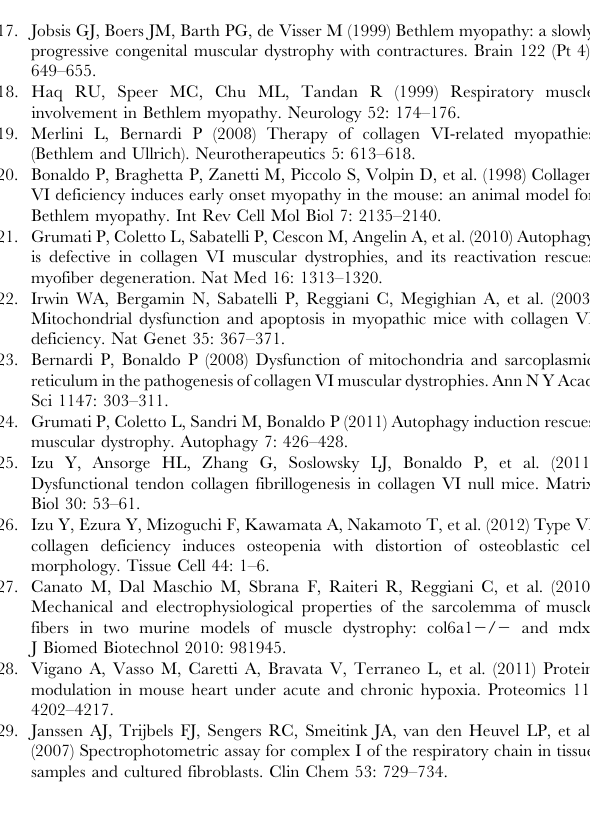
Figure S4 Schematic representation of the different a - ketoglutarate fate in muscles from Col6a1 2 / 2 mice. The direction of IDH1 reaction is controlled by alterations in TCA cycle fluxes leading to the production of anabolic substrates for gastrocnemius and tibialis anterior muscles (panel A), and lipotoxicity for diaphragm muscle (panel B). Figure S5 Myosin heavy chain isoforms composition. SDS electrophoresis was performed on muscle samples using a discontinuous buffer system with a 4% stacking gel (pH 6.8) and a 37% glycerol, 6%T constant concentration running gel (pH 8.8). Samples were separated at 100 V, overnight. Gels were stained with SYPRO Orange (Molecular Probe) and scanned using a 570 nm emission filter on Typhoon laser scanner. Protein band